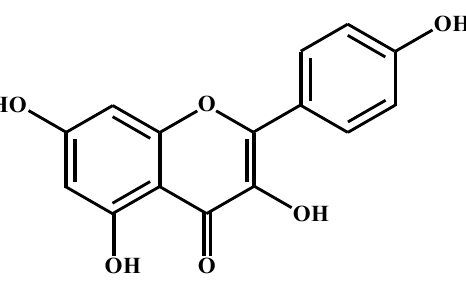
Figure 1. Structure of